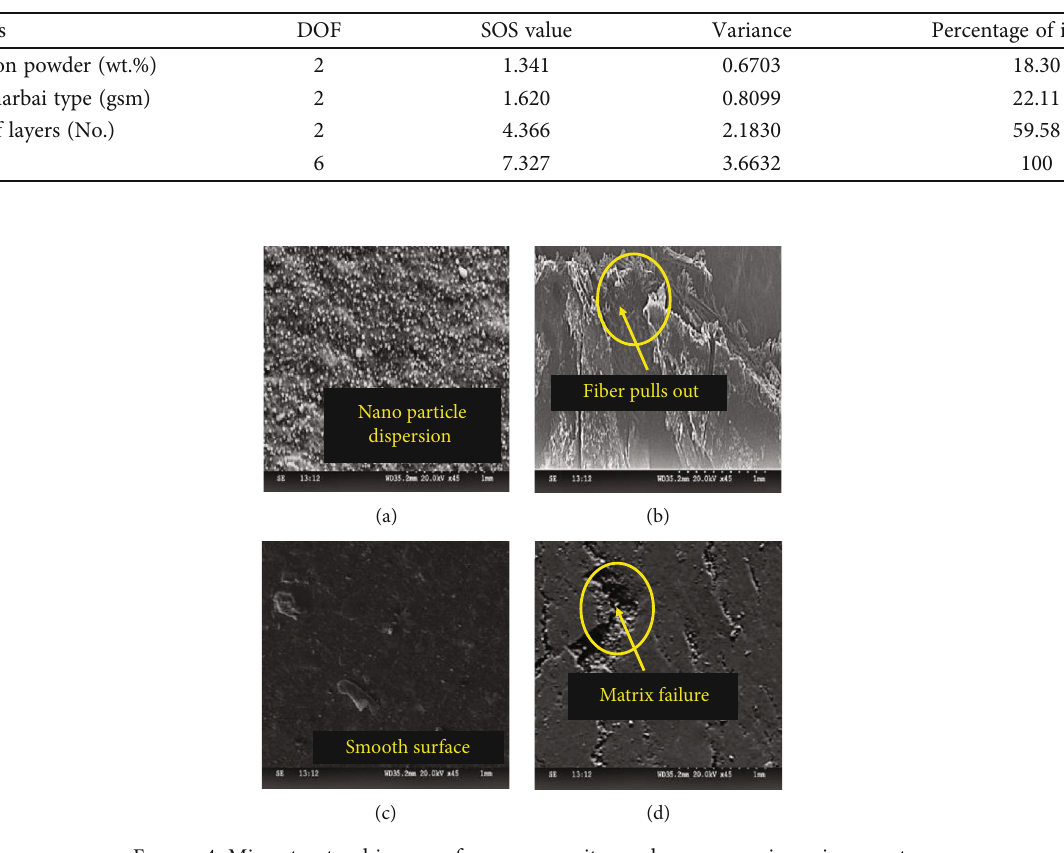
Figure 4: Microstructural images of nanocomposites under a cryogenic